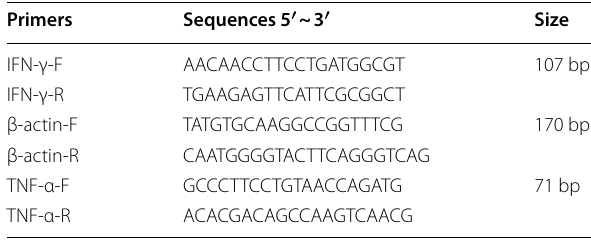
Table 1 Composition and nutrient levels of the basal diet (air-dry basis %)